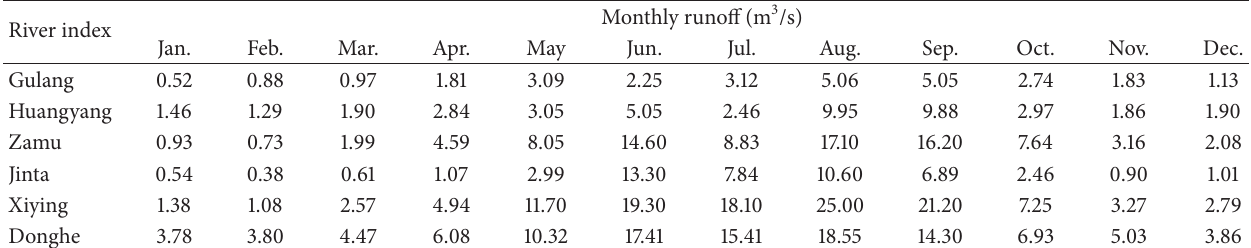
Table 1: The monthly runoff of the six rivers in 2000 ( 𝑃 = 50 %).